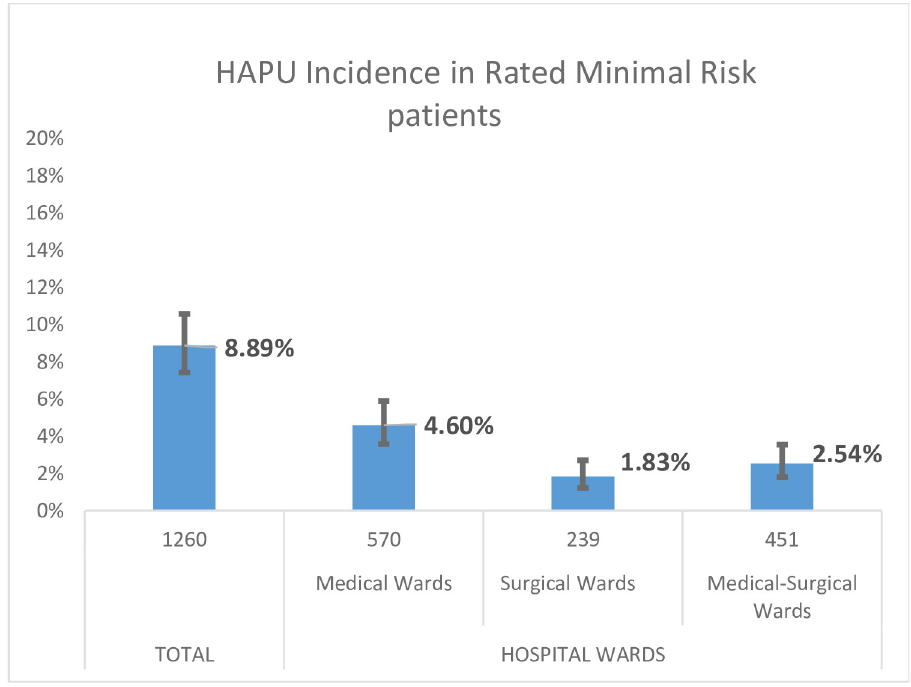
Fig 4. Incidence of HAPU in minimal risk rated patients per nursing care unit. Bars represent 95% confidence interval.